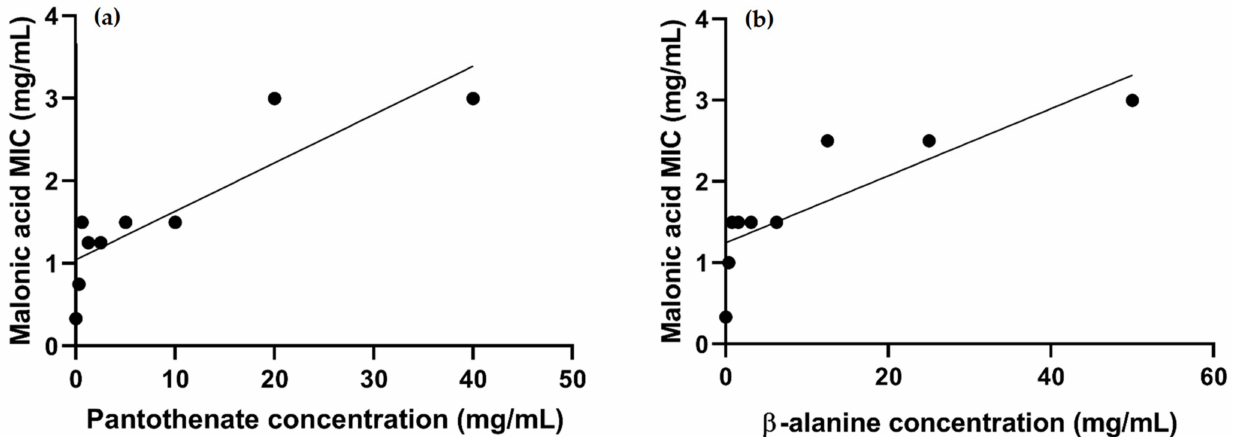
Figure 10. Charts showing the correlation between the MIC of malonic acid against A. baumannii ATCC 19606 and the increasing sub-inhibitory concentrations of the byproducts of the reaction catalyzed by aspartate 1-decarboxylase: ( a ) pantothenate (r = 0.8675); ( b ) β -alanine (r =